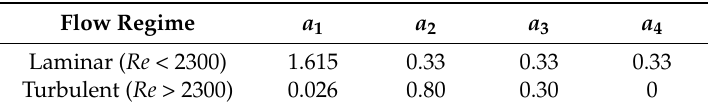
Table 1. Parameter sets for Sherwood and Nusselt correlations